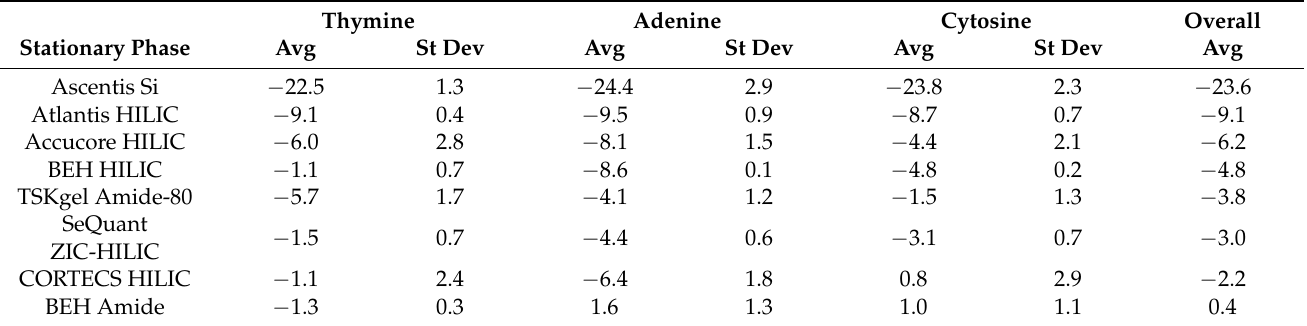
Table 4. Retention factor % changes after 3.09 h of exposure to 60/40 ACN/pH 11.30 ammonium bicarbonate (aq) mobile phase at 70 ◦ C. For each stationary phase three columns were tested, and the averages (Avg) and standard deviations (St Dev) are